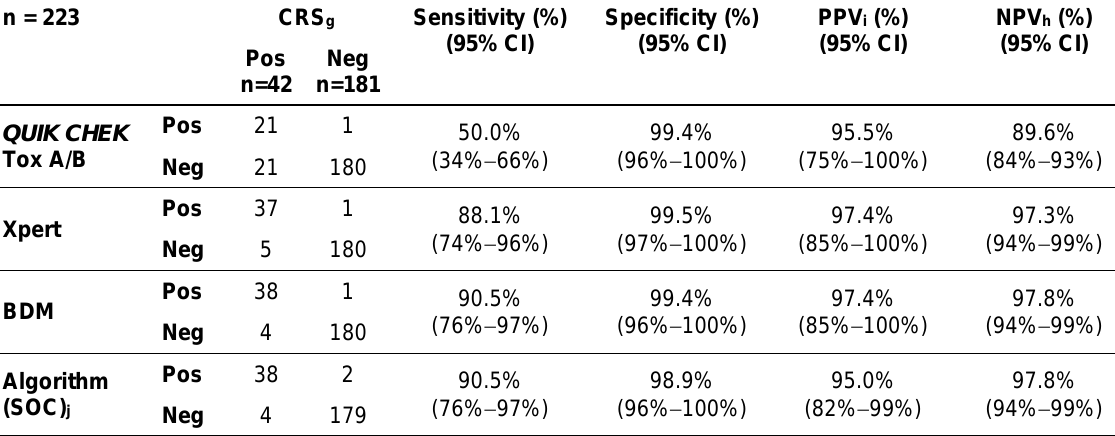
Supplementary Table 1. Performance characteristics of diagnostic assays in comparison withCRS/composite positive on stool samples submitted to the